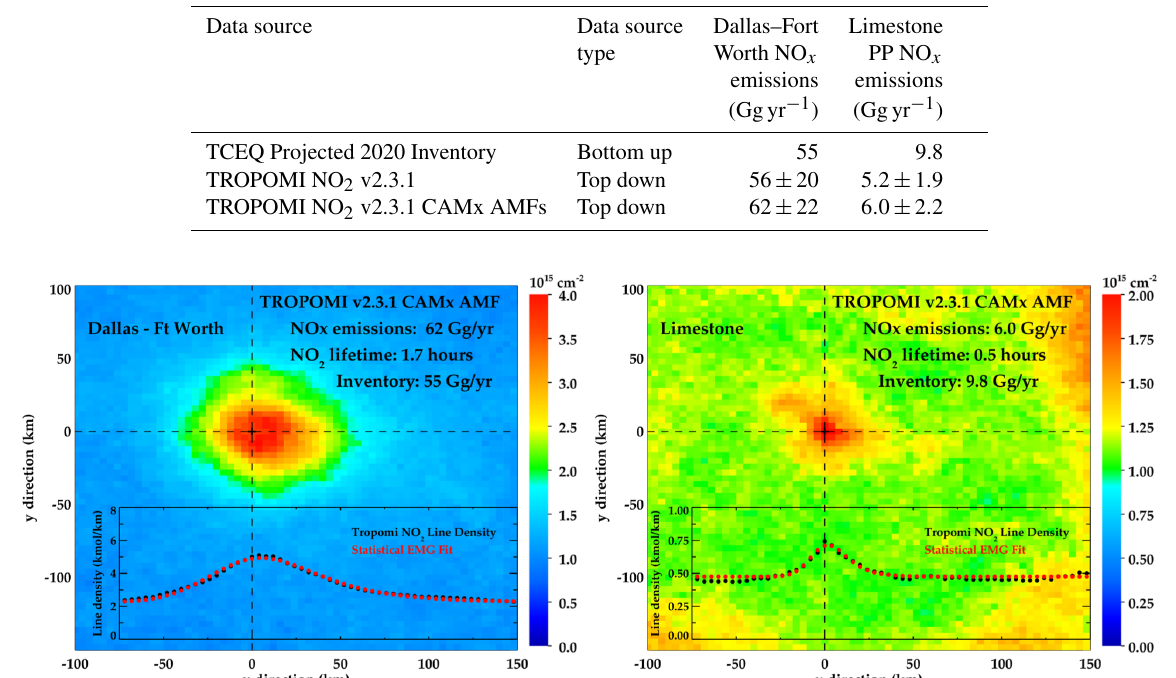
Figure 8. EMG method to derive NO x emissions from the TROPOMI NO 2 v2.3.1 with CAMx AMFs applied to (left panel) Dallas–Fort Worth and (right panel) Limestone power plant. The color bar for the right panel is halved to better show the NO 2 plume near Limestone. ERA5 100m winds are used to rotate daily TROPOMI NO 2